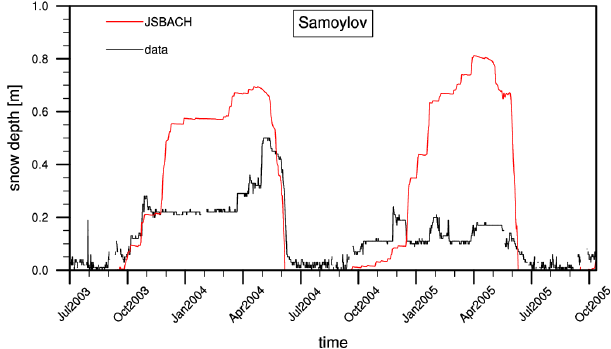
Fig. 7. Observed and simulated snow depth at the Samoylov site.